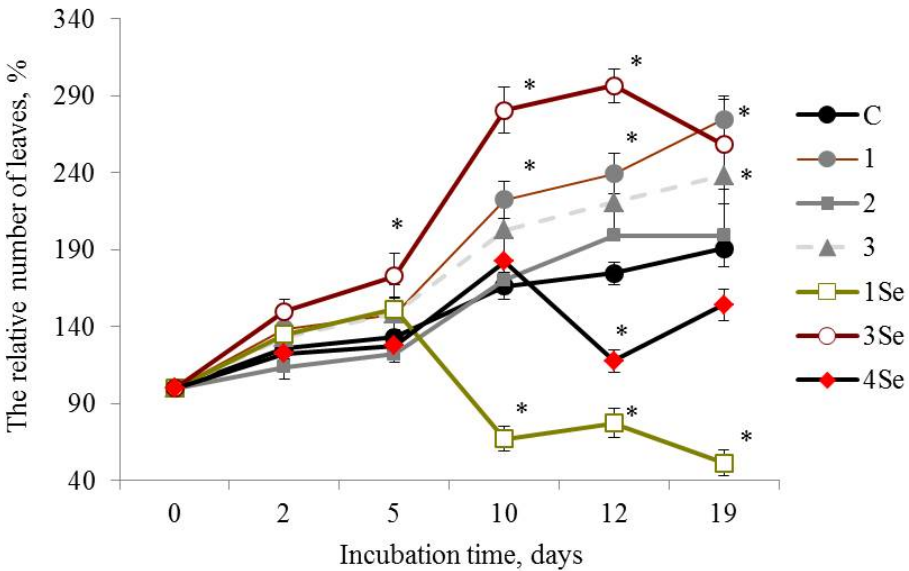
Figure 2. Influence of bio-composites on the relative (percentage to “0 day”) number of plants leaves in Lugovskoi potato cultivar in vitro. C—control without treatment by fungal bio-composites; 1, 2 and 3—treatment by fungal biopreparations without Se based on Grifola umbellata , Ganoderma lucidum 1315 and Pleurotus ostreatus , respectively; 1Se, 3Se and 4Se—treatment by fungal bio-composites with Se based on Gr. umbellata ; P. ostreatus and G. lucidum SIE1303; * p ≤ 0.01 compared to control.